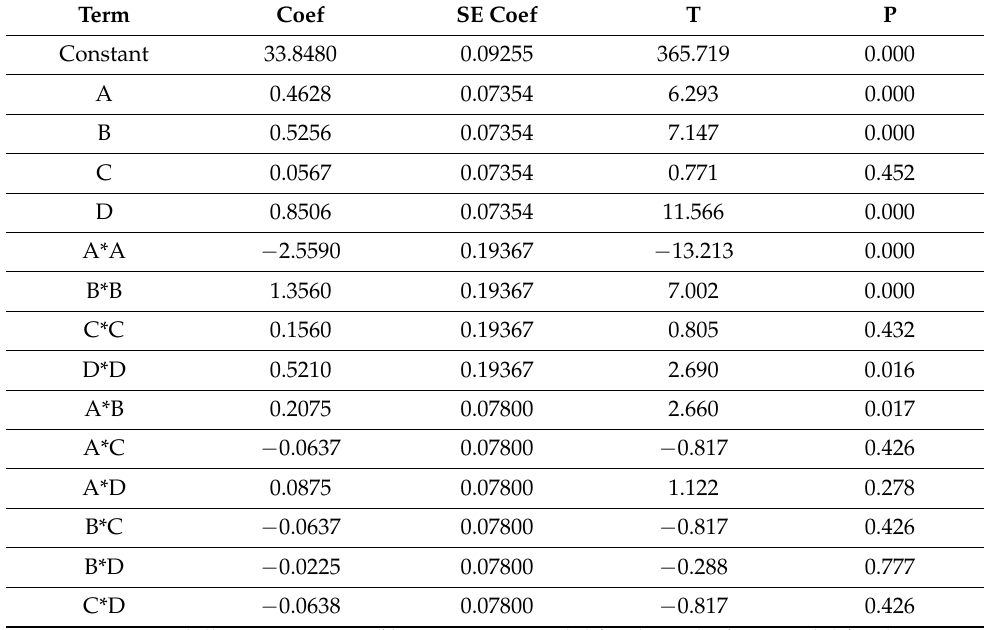
Table 12. Estimated regression coefficients for thermal conductivity (W/m · K). Term Coef SE Coef T